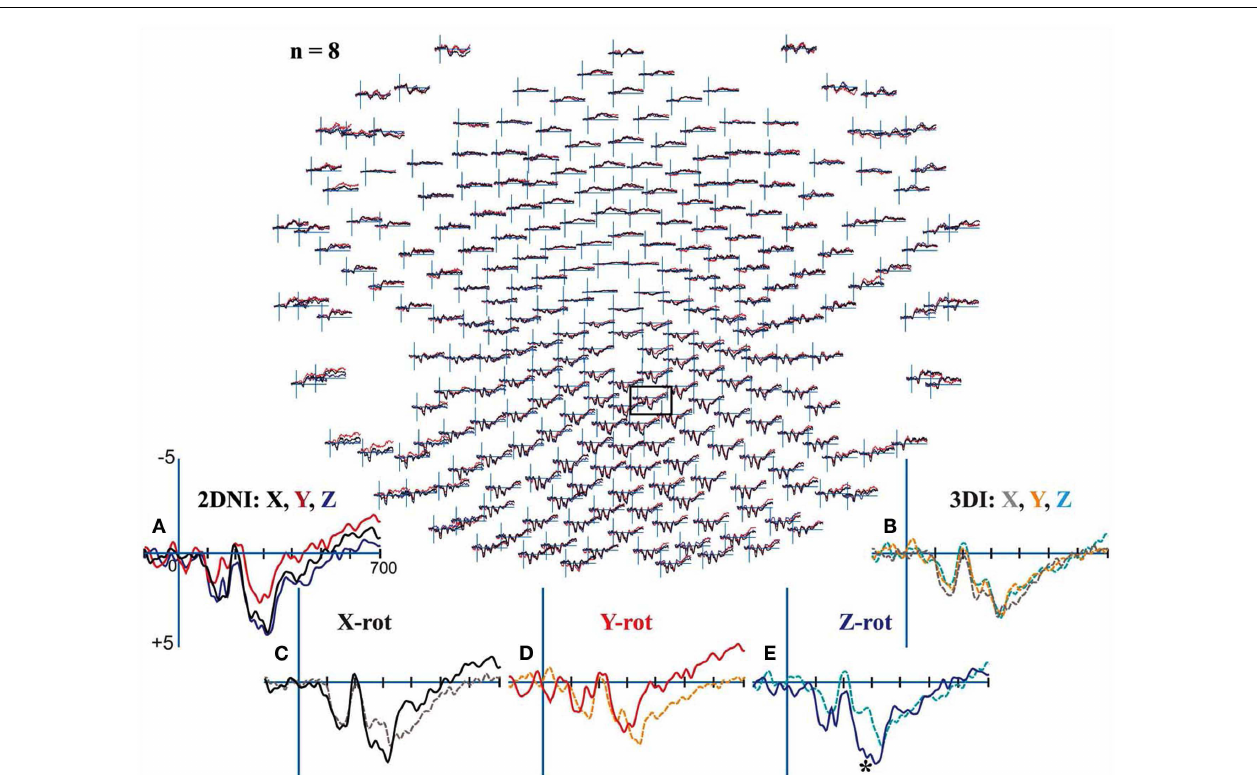
to X rotations at ∼ 350ms. (C–E) When comparing rotations between 2DNI and 3DI environments 3DI rotations demonstrated a trend for greater negativity prior to 350ms but slightly larger positivity at longer latencies > 350ms.The largest differences were between Z -rotations which were more positive for 3DI at ∼ 270–300ms, ( ∗ ) with paired t -test p < 0.03.